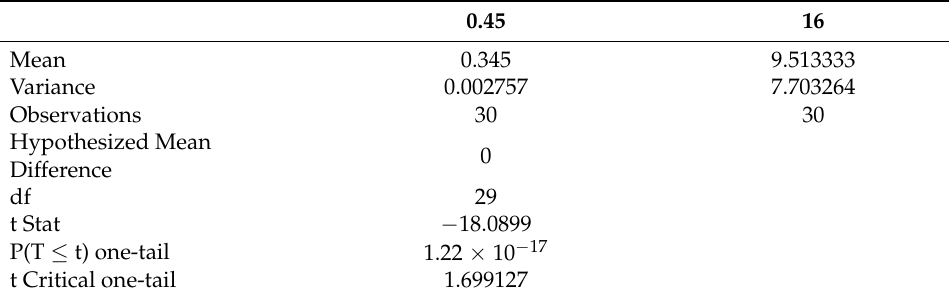
Table 6. t -test result between RFA and AI for left and